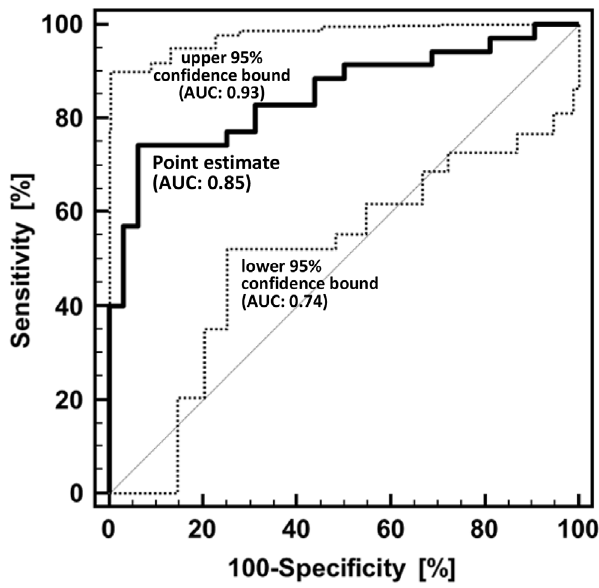
Figure 2. Receiver operating characteristic (ROC) curve analysis of serum Angpt-2 to diagnose CC. ROC analysis allows the evaluation of the binary classification variable (presence of CC=1, absence of CC=0) at different thresholds of Angpt-2 levels. The area under the curve (AUC) value for the point estimate (thick solid line) was calculated to be 0.85. The 95% confidence interval (CI) as the probability range in which the estimate is expected in 100 different cohorts of patients with equally distributed Angpt-2 levels ranges from an AUC of 0.74 in the worst case to 0.93 in the best case (thin dotted lines). The 95% CI is therefore a measure for the reliability of Angpt-2-based CC diagnosis. For testing the performance of Angpt-2 the departure of its AUC from 0.5 (a random classifier) was assessed by using a standard t test, which resulted in a p-value of , 0.0001 for the point estimate.